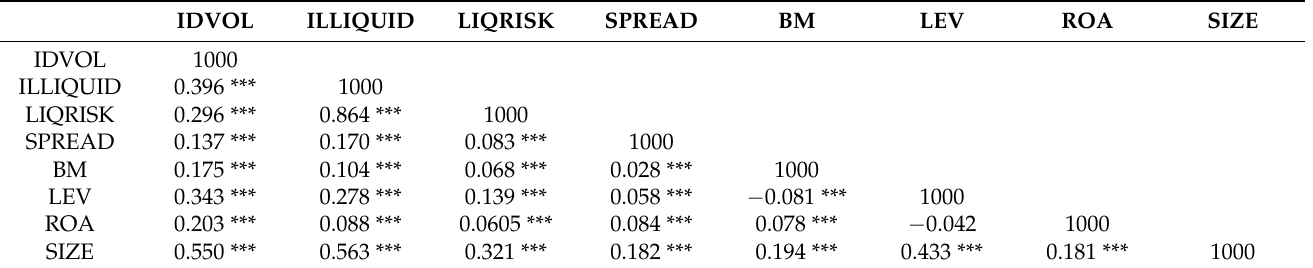
Table 3. Correlations.